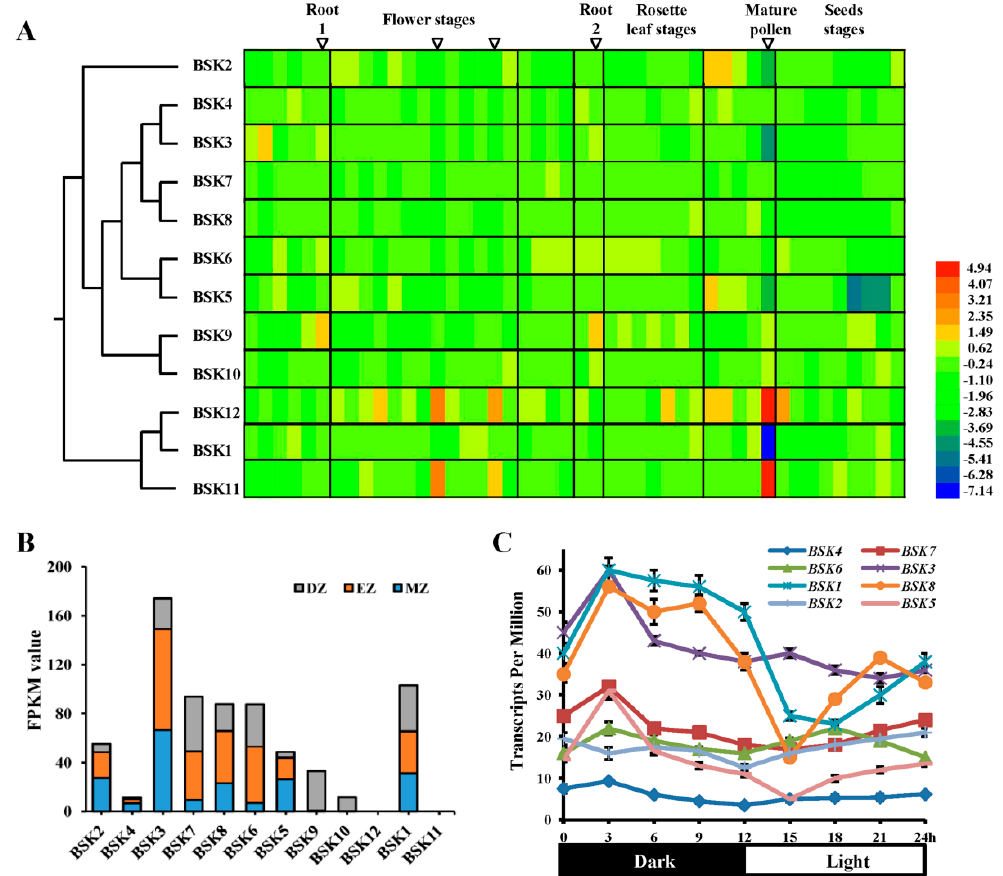
Figure 5. Development- and tissue-specific expression profiles of Arabidopsis BSK genes. ( A ) Heat map of the relative expression levels of all identified Arabidopsis BSK genes during development process. The colour bar represents the expression values. Samples from specific developing stages of Arabidopsis for gene expression analysis were highlighted with inverted triangles, such as roots from seedlings (1) and mature plants (2). ( B ) Expression profiles of BSK genes in specific root regions. DZ: division zone; EZ: elongation zone; MZ: mature zone. ( C ) Expression profiles of BSK genes across one light:dark cycle.